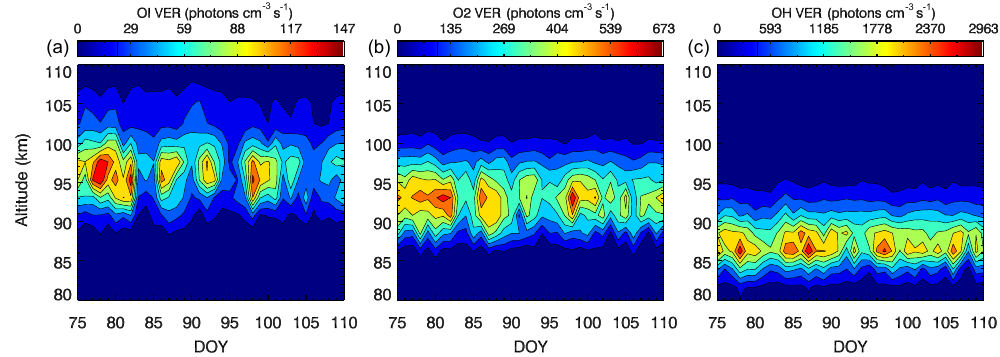
Figure 1. Time–altitude distribution of the volumetric emission rates of the OI5577 (a) , O 2 b (0–1) (b) , and OH(6–2) (c) at 43 ◦ N and 143 ◦ E. Time interval covers March and April for 2005 simulations.